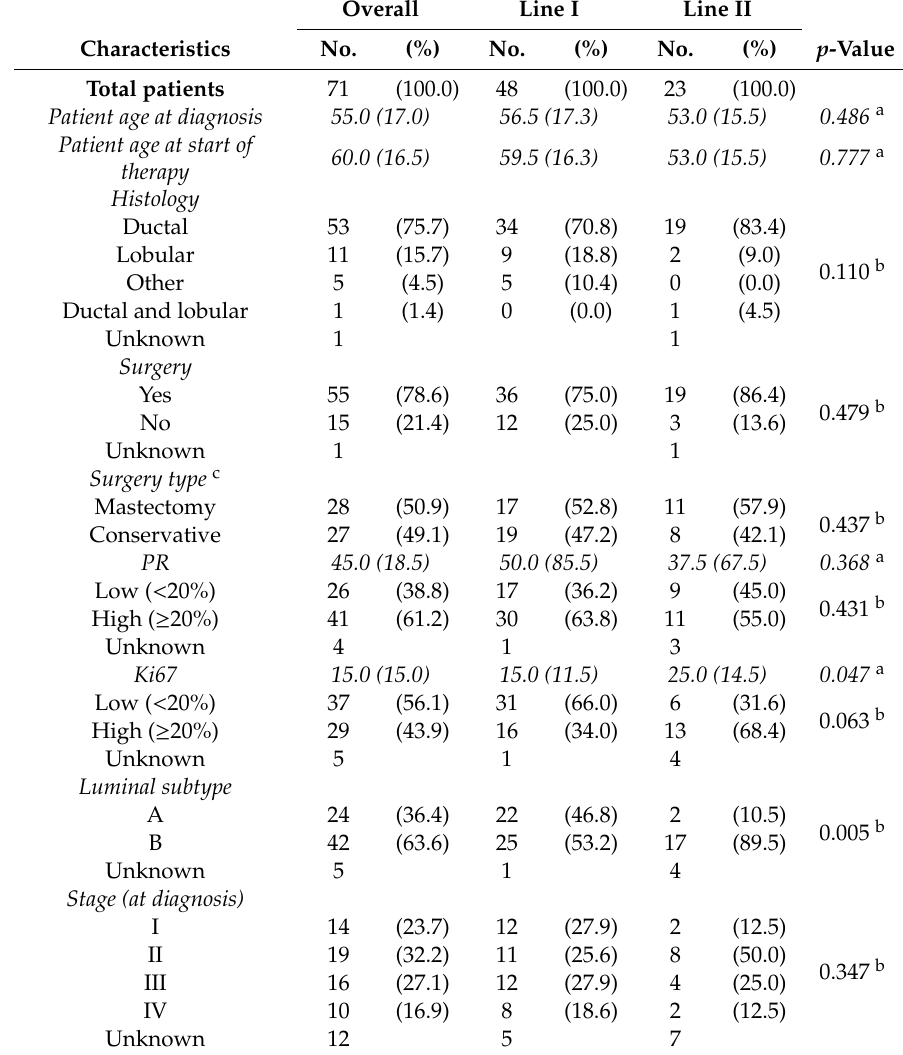
Table 1. Patient characteristics: overall and by line of treatment (results on continuous data are reported in